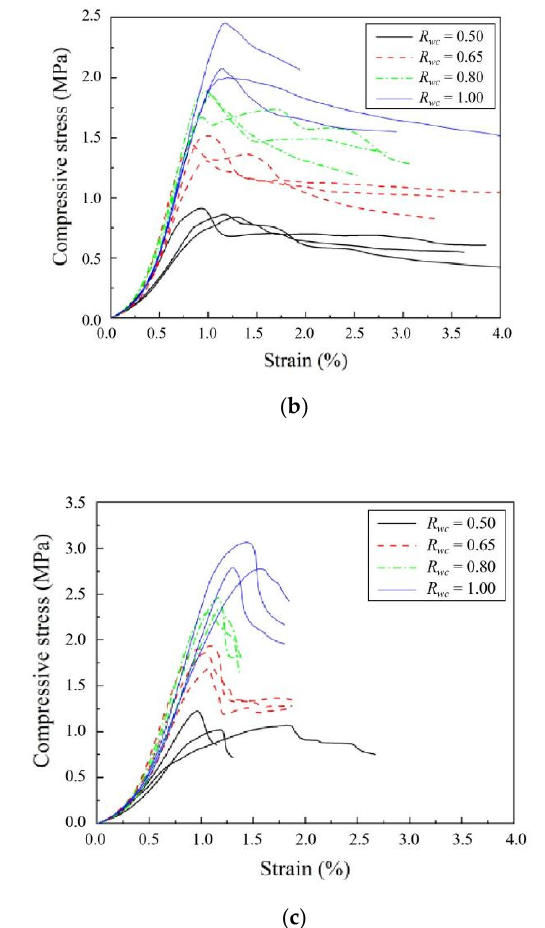
Figure 4. Stress-strain curves of foam concrete at the ages of ( a ) 3, ( b ) 7 and ( c ) 28 days with the R sc of 2 at various R wc .